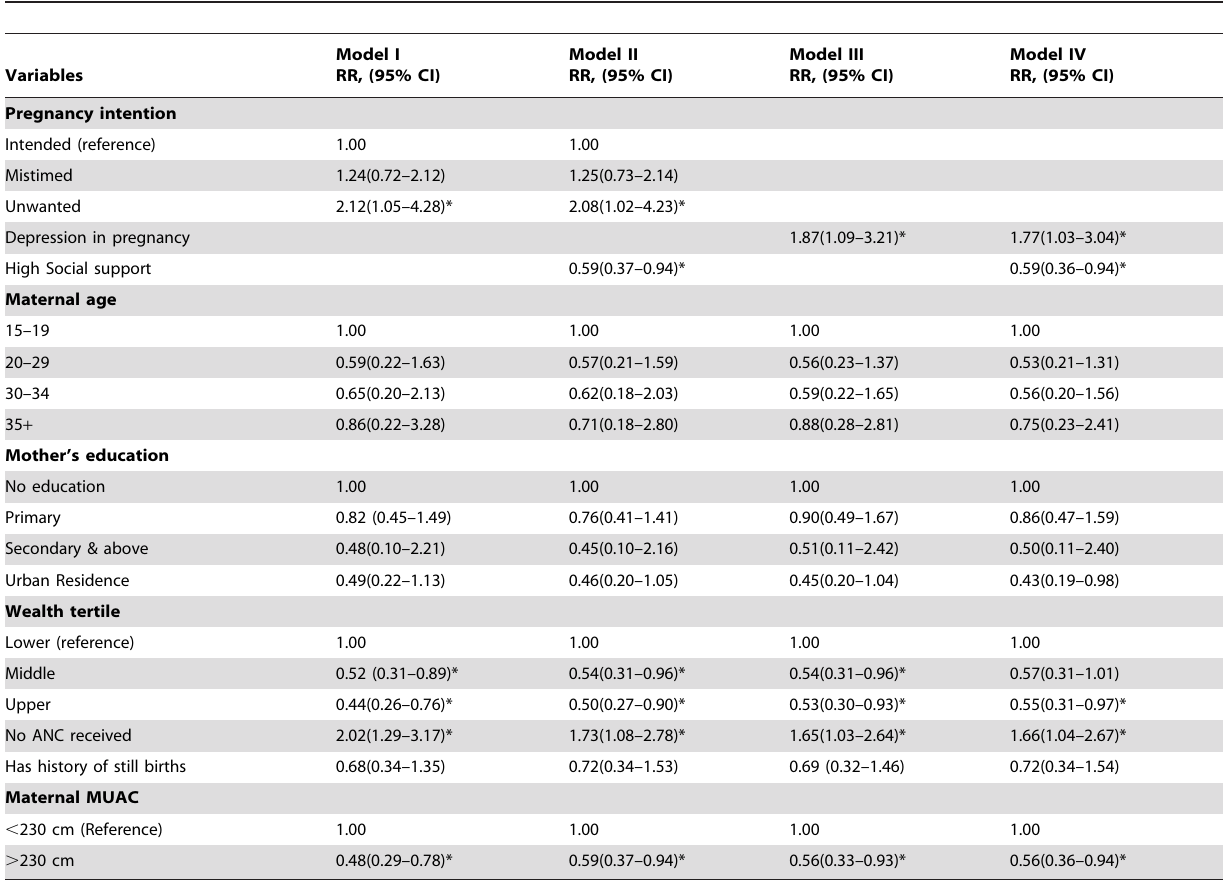
Table 2. Relative risks from log binomial regression analysis showing association between pregnancy intentions, maternal depression and social support with Low Birth Weight, Southwest Ethiopia,